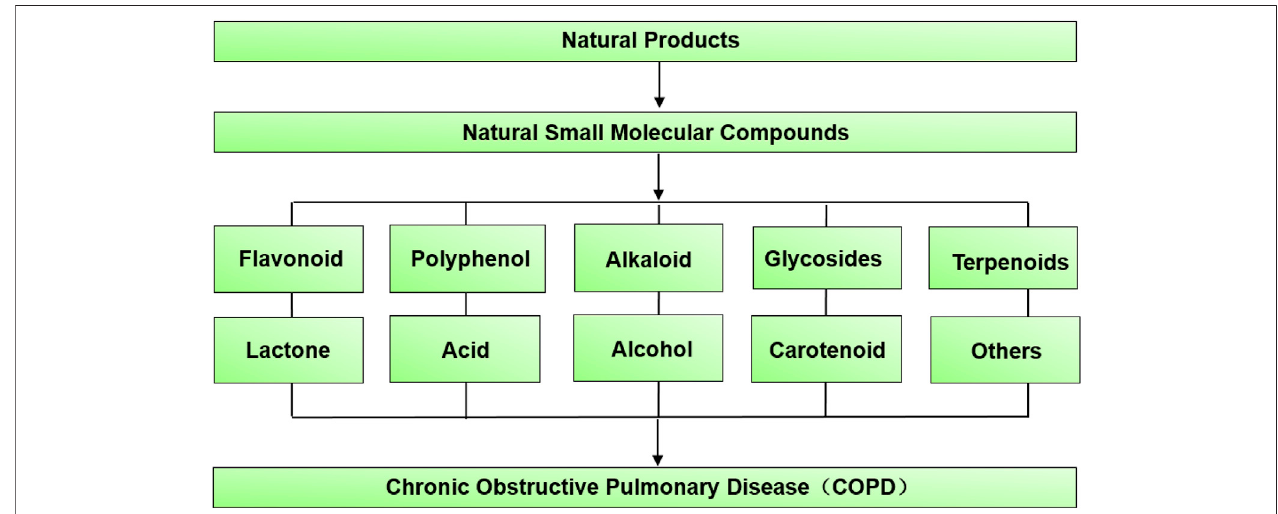
FIGURE 1 | The 10 kinds of natural small molecular compounds that have an effect on COPD.